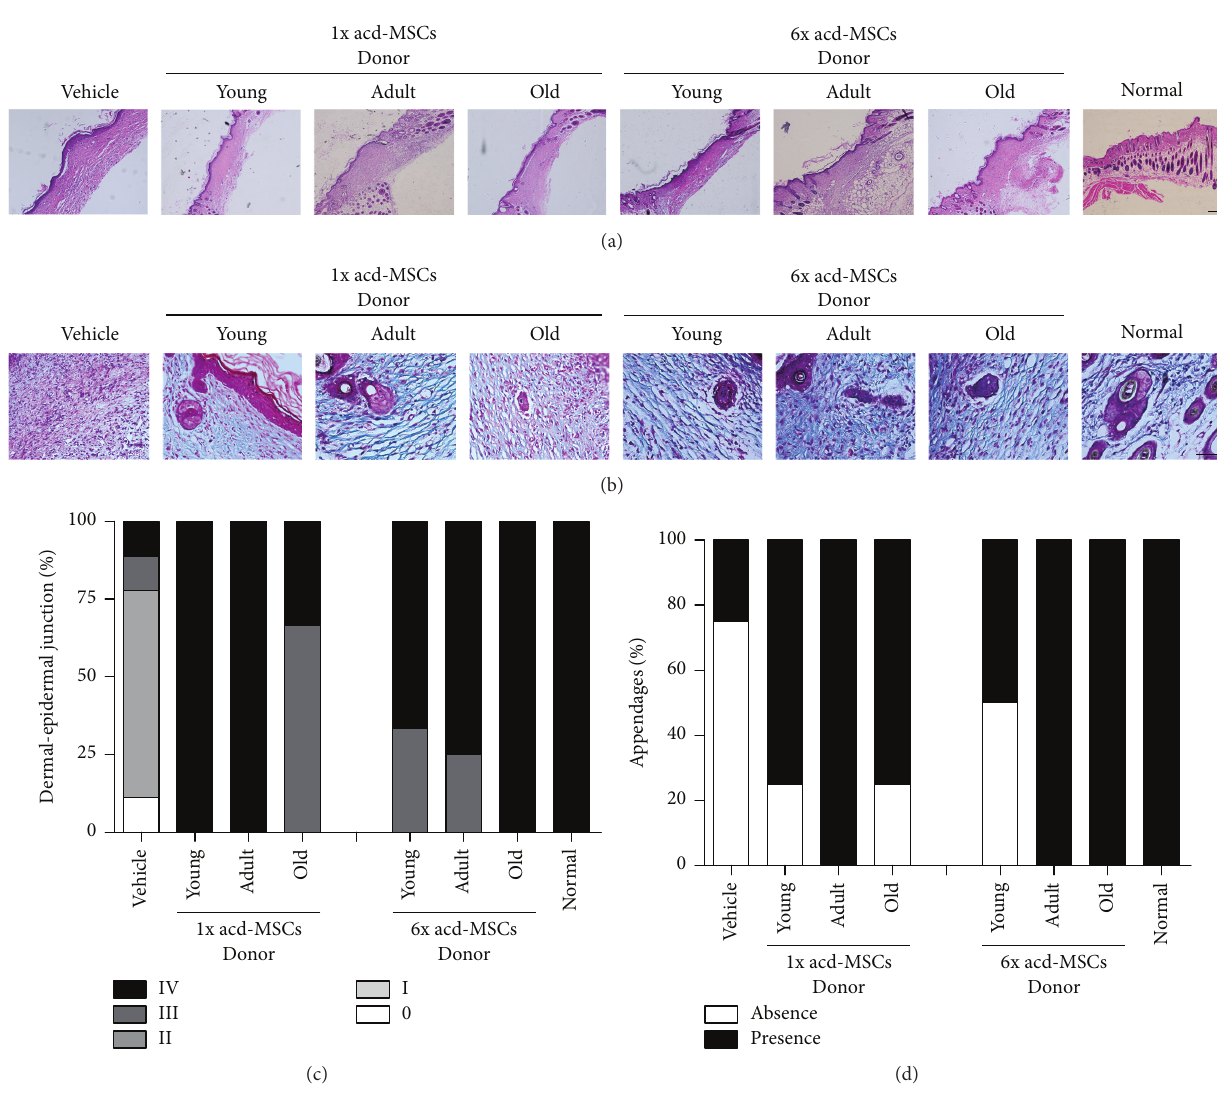
Figure 6: acd-MSCs led to the recovery of quality regenerated skin. Histological section images 12 days after treatment. (a) Haematoxylin- eosin stain that represents the dermoepidermal junction. Scale bar 100 𝜇 m. (b) Masson’s trichrome stain that showed appendage-like structure inthedermis.Scalebar50 𝜇 m.Frequency(%)ofanimalswith(c)differenthistologicalscoresofdermoepidermaljunctionand(d)histological scores of appendage structure. Representative results for 6–12 animals per experimental